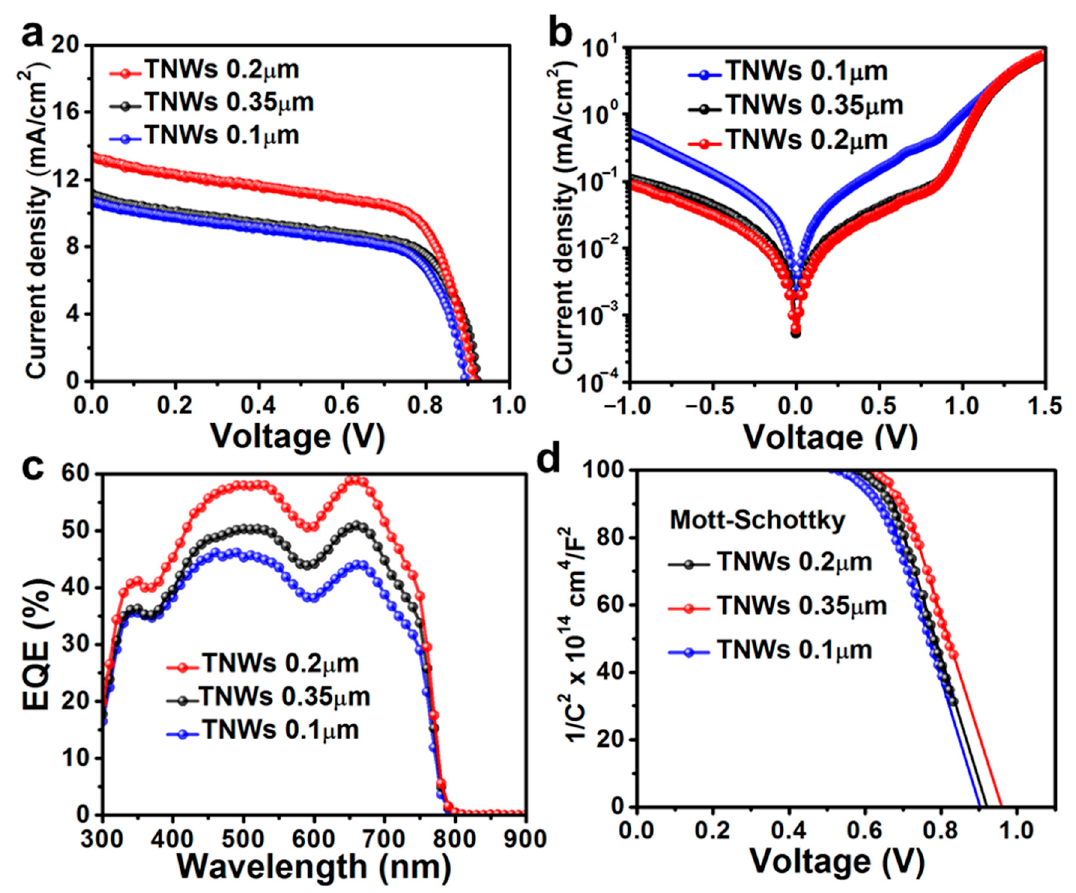
Figure 2. ( a ) Top rough surface of the TNWs and, ( b ) conformal CH 3 NH 3 PbI 3 coated TNWs, ( c – e ) Cross-sectional FESEM images of solid-state TNWs/Perovskite solar cells with compact TNWs lengths of 0.35 µm, 0.2 µm, and 0.1 µm. All figures have scale bar of 0.5 µm.